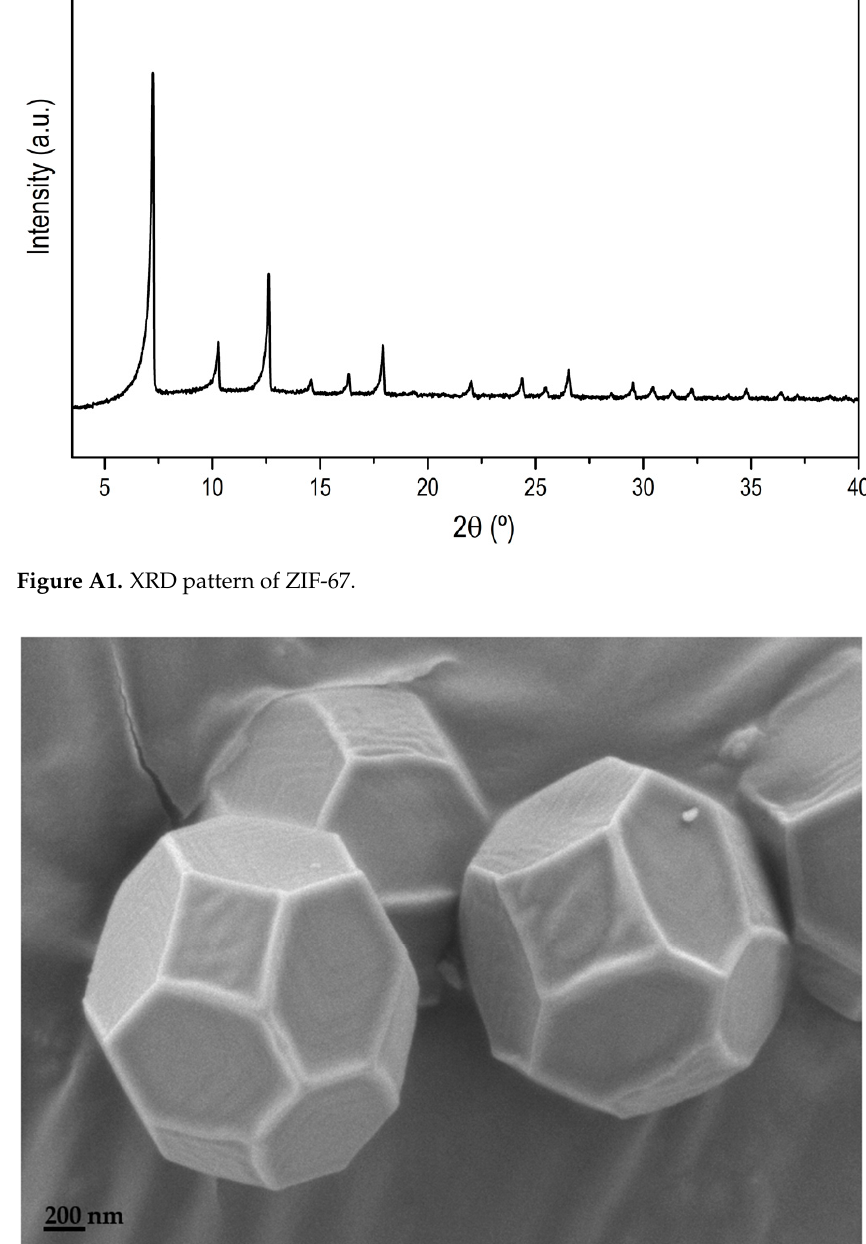
Figure A2. SEM micrograph of ZIF-67.